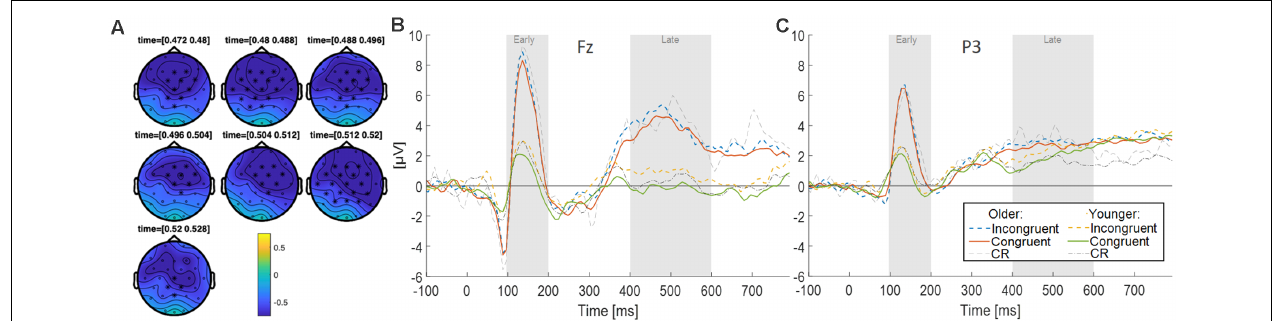
FIGURE 3 | (A) Scalp topographies during the time-span of the most prominent clusters due to congruence. Electrodes belonging to the cluster are highlighted with asterisks. (B) ERP responses (electrode Fz) for three conditions (Congruent vs. Incongruent vs. Correct Rejections) and age groups (Younger vs. Older adults). (C) ERP responses (electrode P3) for three conditions (Congruent vs. Incongruent vs. Correct Rejections) and age groups (Younger vs. Older adults). The analyses for both electrodes focused on an early (100–200 ms) and a late (400–600 ms) time window.